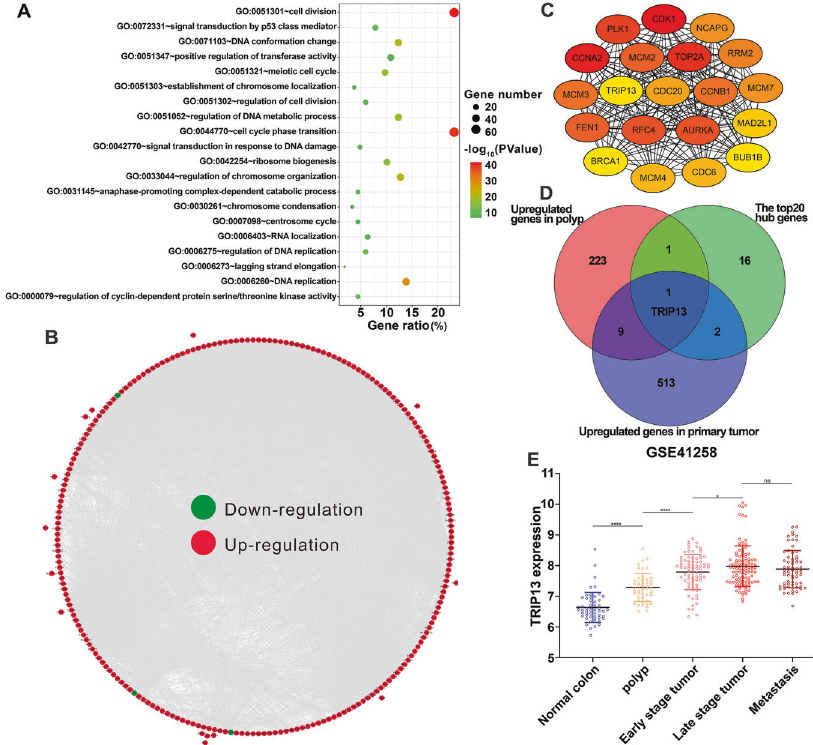
Fig. 2 Functional pathways enrichment analysis and selection of hub genes in the blue module. A Heatmap of top 20 functional path enrichment analysis. B PPI network of the blue module genes. C The top 20 hub genes identi fi ed from the whole network by using the radiality algorithm of plug-in cytoHubba. D Venn diagram of the top 20 hub genes, the upregulated genes of polyp vs. normal tissues, and the upregulated genes of primary tumor vs. polyp tissue in GSE41258 dataset. E TRIP13 expression of normal, polyp, early stage tumor, late stage tumor, and metastasis tissues in GSE41258 dataset.* p < 0.05, **** p < 0.0001; ns, no signi fi cant